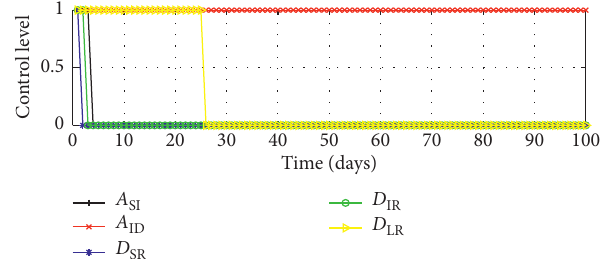
Figure 4: Optimal dynamic control with charging factors. This figure shows how the five control variables change over 100 days.